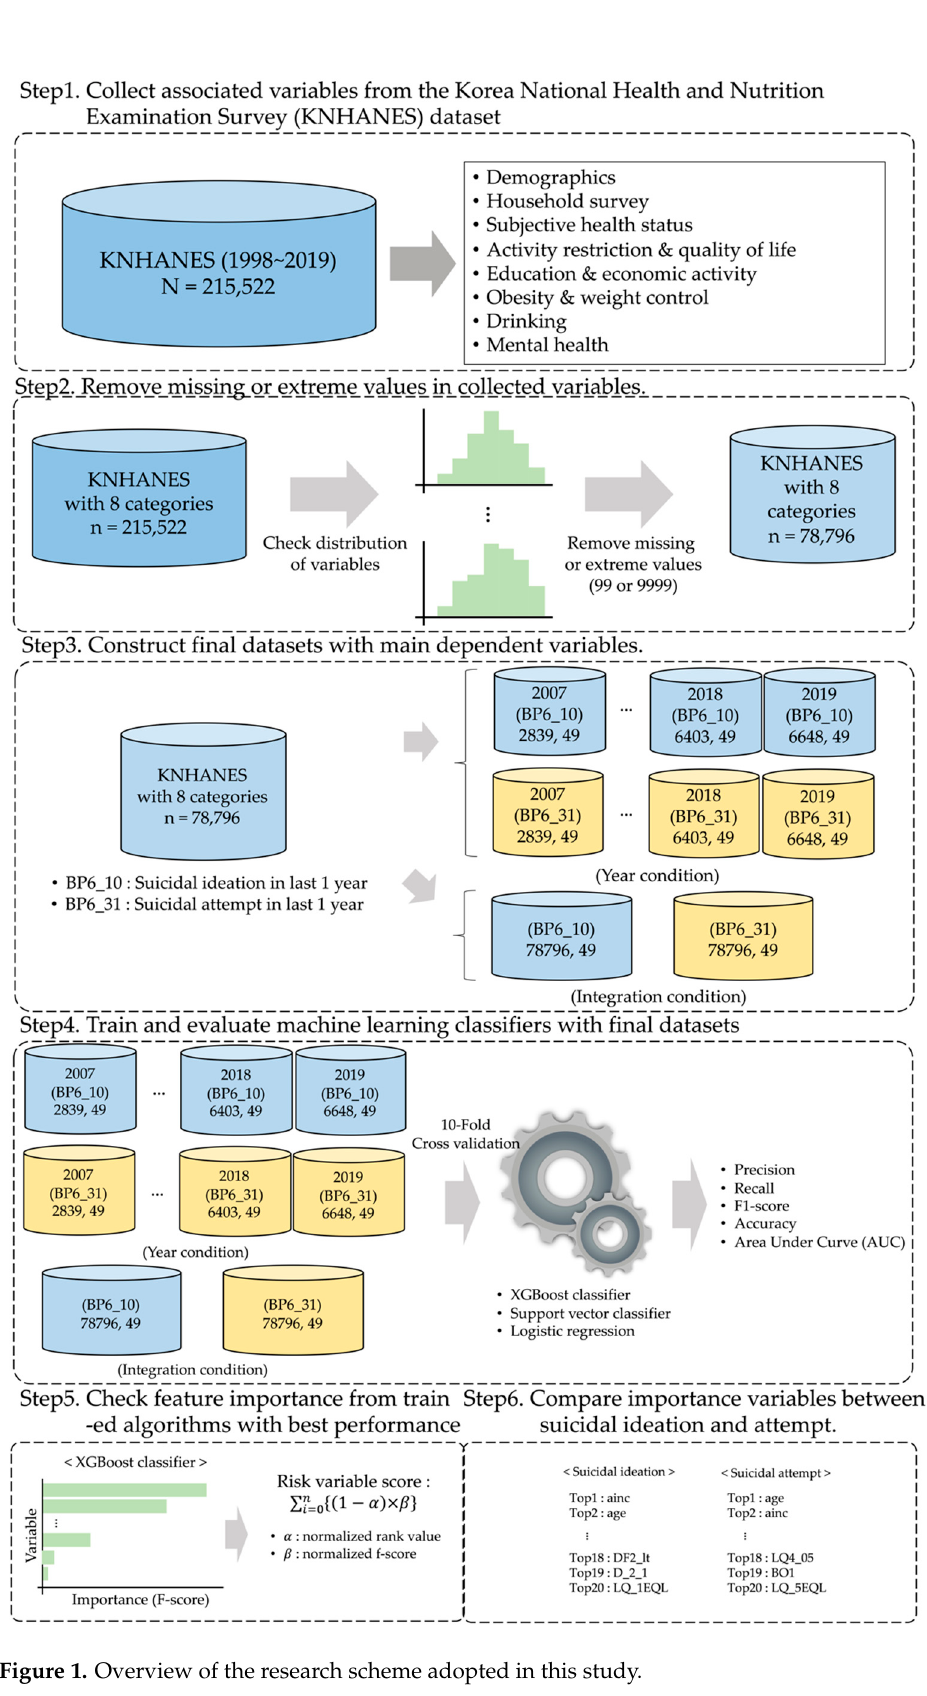
Figure 1. Overview of the research scheme adopted in this study.